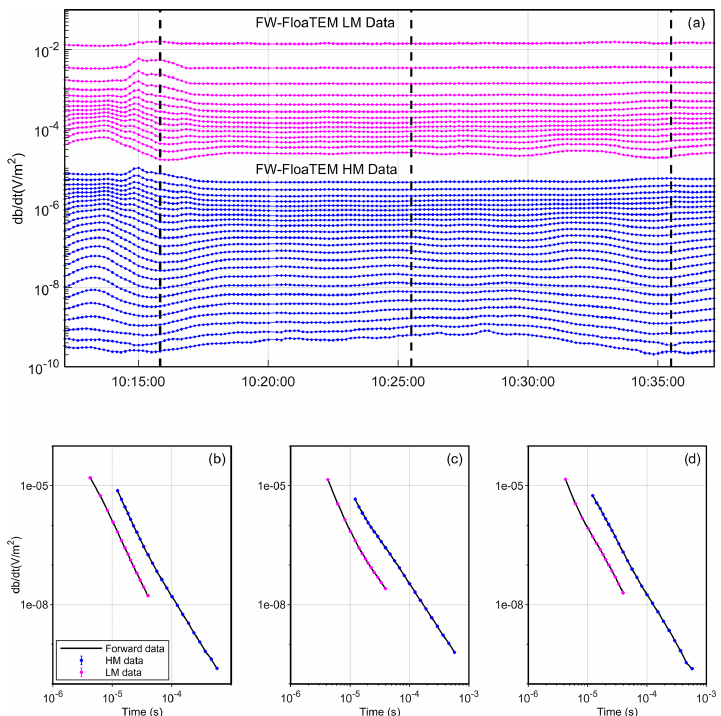
Figure A1. An example of data acquired using the FW-FloaTEM system. Panel (a) shows the TEM data in profile view where each profile represents a gate; panels (b–d) show the transient decays shown, respectively, at three times marked as three vertical dashed lines in (a) .